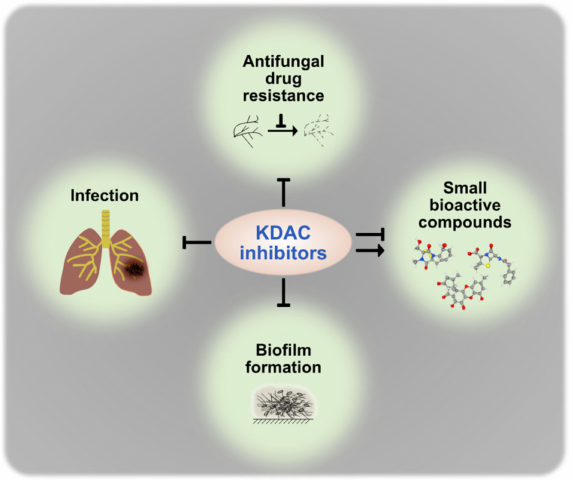
Figure 3. Effects of KDACIs on virulence-specific traits and SM production of